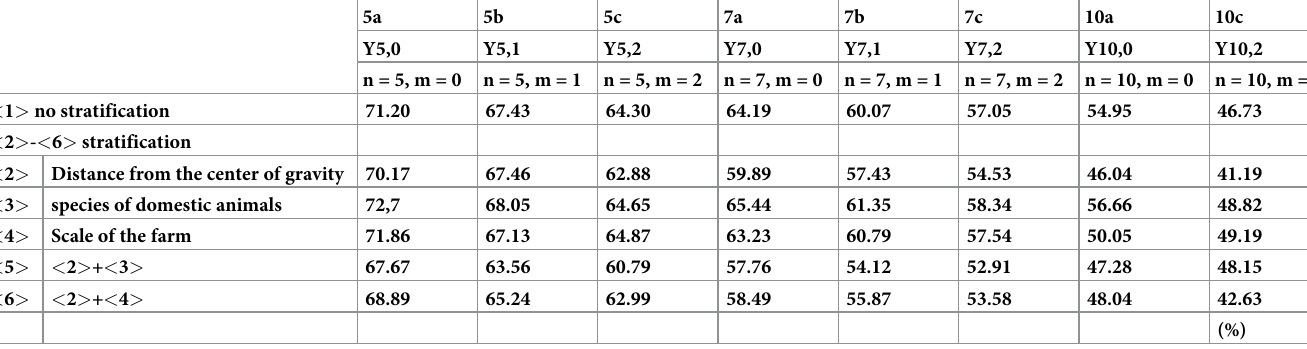
Table 2. Results of evaluation experiment (performance comparison for